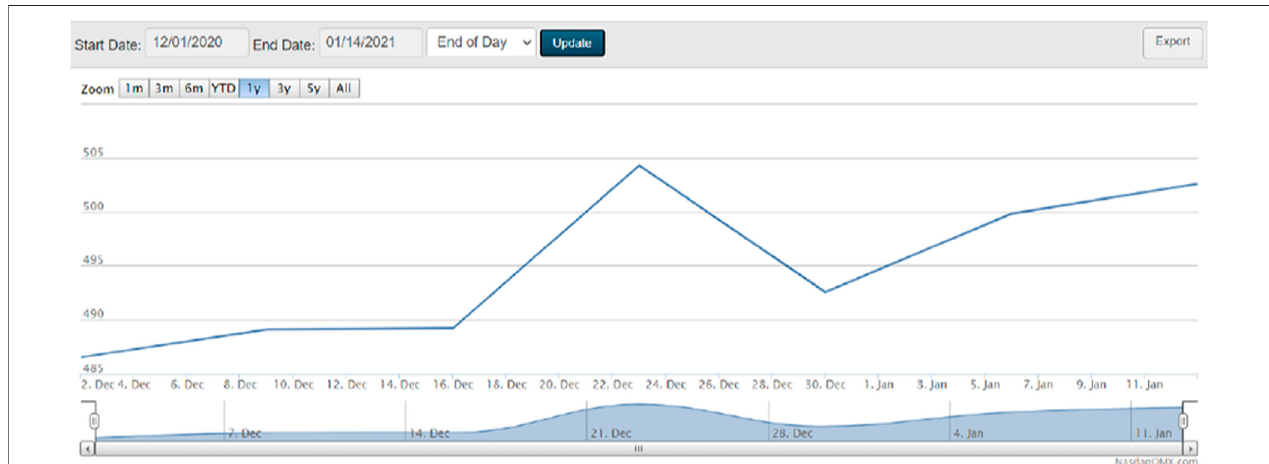
FIGURE 7 | Water per acre/ft, 1 December 2020-14 January 2021. Source: Nasdaq (2020).